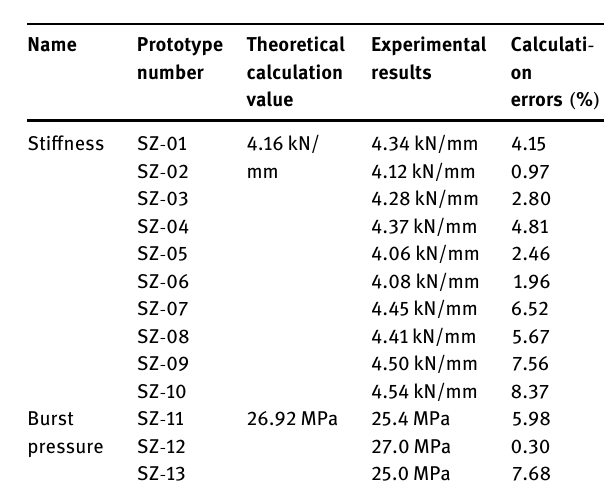
Table 2: Mechanical performance test